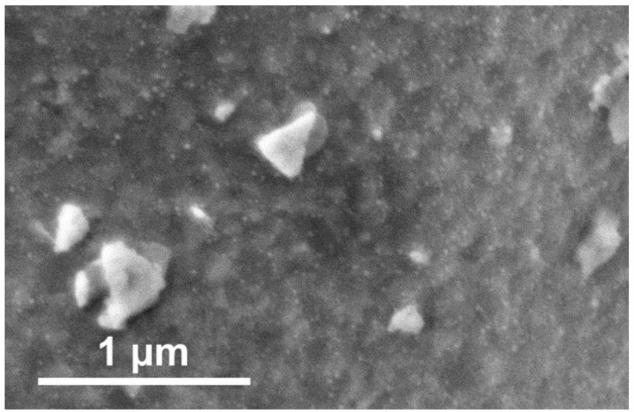
Figure 5. SEM image of Nd 0.6 Ca 0.4 Fe 0.9 Co 0.1 O 3- δ after the double ramp experiment with an end temperature of 570 ◦ C. Finely dispersed nanoparticles were visible on the surface, but no formation of CaCO 3 crystallites could be observed.